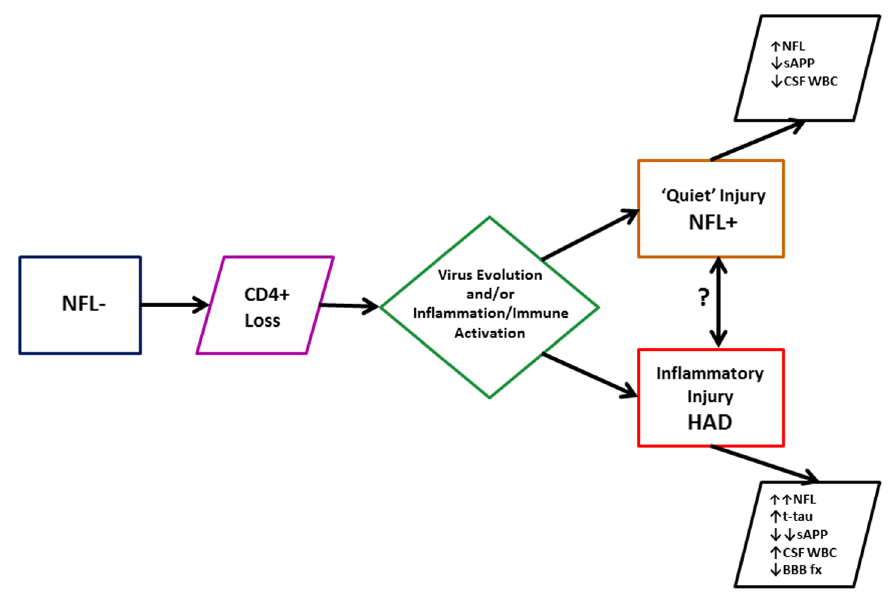
Fig. 4. Progression to severe HIV-related CNS injury. The figure outlines a simple diagram of transition from asymptomatic NFL- infection to either ‘quiet’ NFL + injury or HAD. It emphasizes that both have CD4 + T-cell loss in common but then diverge for undefined reasons, possibly related to viral evolution of host inflammatory/immune activation characteristics. Further study is needed to understand the factors operating in this transition. It also has not been defined whether either of these two injury states can transition to the